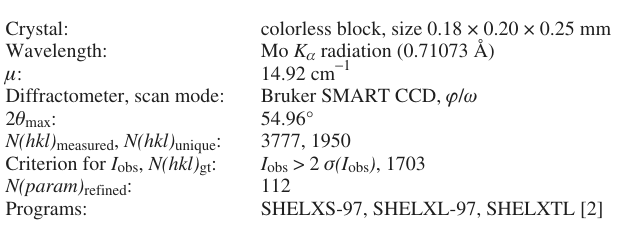
Table 1. Data collection and handling.